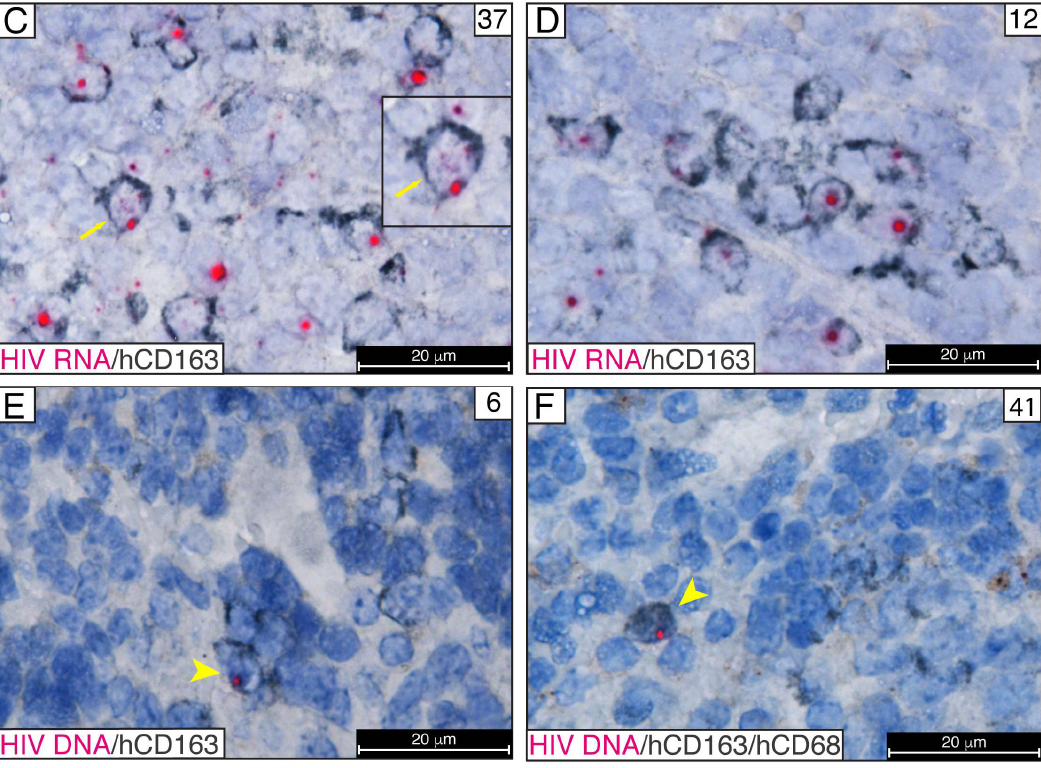
Figure 8. Human CD163 + macrophages harbor HIV proviruses during fully suppressive EFdA treatment. HIV-infected macrophages in NSG-BLT mouse spleens were detected by combined chromogenic RNAscope ISH and immunohistochemistry using anti-human CD163 mAb. HIV RNA was identified using an HIV- gag-pol antisense probe ( A , C , D ), and HIV DNA was identified using an HIV-1 clade B sense probe ( B , E , F ). Thirty to fifty images of representative white pulp regions containing human lymphoid and myeloid cells were acquired at a magnification of 630×. ImageJ software enumerated HIV RNA + cells, HIV DNA + cells, and hCD163 + cells. The numbers of HIV RNA + macrophages ( A ) and HIV DNA + macrophages ( B ) were normalized to total HIV RNA + or DNA + cells per image and expressed as a percentage. The Mann–Whitney U-test performed the statistical comparison between groups and were not significant ( P > 0.05). HIV RNA ( C , D ) and HIV DNA ( E , F ) were visualized by alkaline phosphatase-Fast Red fluorescence detection. ( C – F ) Nuclei were counterstained with hematoxylin. The yellow arrow shows hCD163 + macrophages containing HIV RNA signals in the nucleus (because the probe also detects the sense strand of integrated HIV DNA) and cytoplasm. The yellow arrowhead shows HIV DNA + macrophages identified by anti-human CD163 mAb ( E ) or a pool of anti-human CD163 and CD68 mAbs ( F ). Tissue numbers in ( C – F ) indicate mouse numbers shown in panels ( A ) and ( B